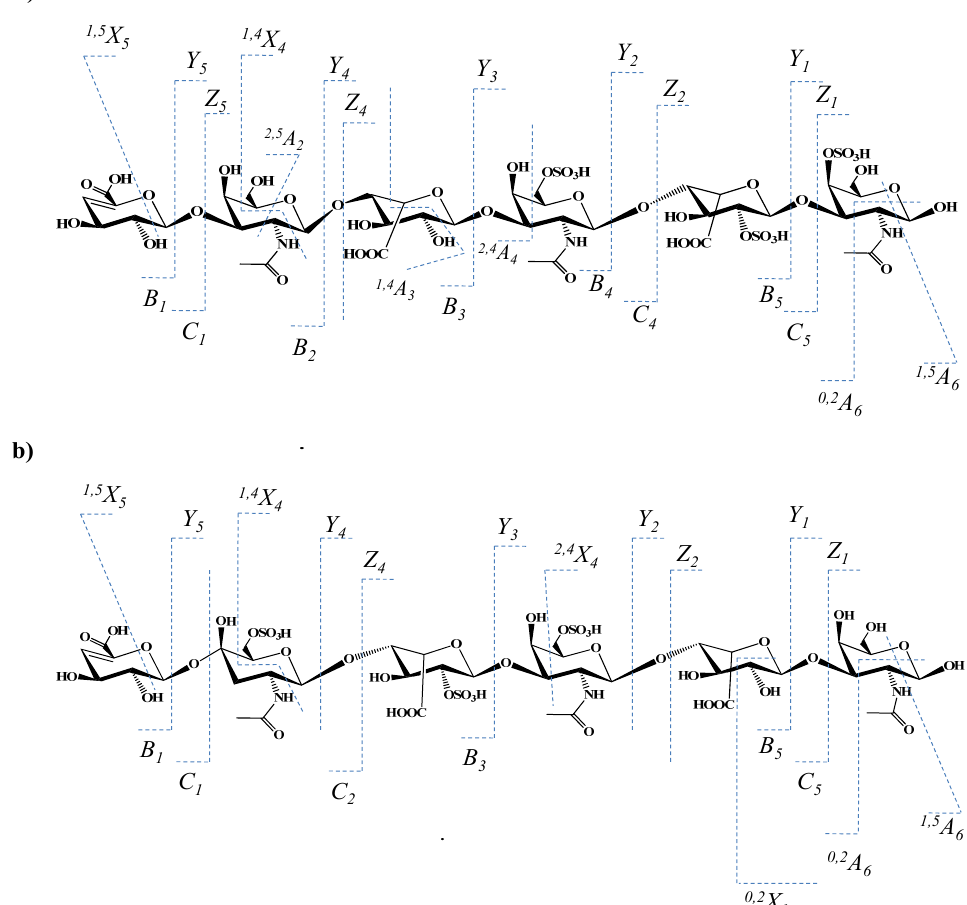
Figure 8. The two proposed structures with three sulfates located at the GalNAc-IdoA-GalNAc trisaccharide sequence from ( a ) the reducing or the ( b ) non-reducing end, together with the fragmentation pathways and the observed fragment ions for the trisulfated 4,5- Δ -GlcAGalNAc[IdoAGalNAc] 2 . The series of fragment ions detected by CID support both structures depicted in Figure 8. Due to the symmetry of the inner GalNAc-IdoA-GalNAc-IdoA-GalNAc motif and the lack of an aglycone to be used as a “tag”, no fragment ion able to support or completely rule out the structure in Figure 8a may be generated. On the other hand, on the basis of the previous observations related to the unsulfated 4,5- Δ -GlcA, the structure in Figure 8b is to be supported solely by fragment ions from the non-reducing end, hav- ing the nonsulfated 4,5- Δ -GlcA as a “tag”, to yield 4,5- Δ -GlcA-GalNAc-IdoA-GalNAc with all three sulfates located in GalNAc-IdoA-GalNAc. In spite of the high sequence coverage provided by the CID experiment and the el- evated mass accuracy of the generated fragment ions, none of the diagnostic ions was detected in the MS/MS of the trisulfated 4,5- Δ -GlcAGalNAc[IdoAGalNAc] 2 species. However, given that the absence of a signal does not represent relevant information, in Figure 8a,b we propose two structural variants for the analyzed trisulfated hexasaccha- ride. However, since the IMS profile has shown a single mobility feature for the triply charged molecule at m/z 470.714, only one of these two glycoforms represents a genuine domain in the CS/DS chain. Without IMS, the occurrence of both isomeric motifs should have been considered. In view of the MS/MS issues presented above, we deem that the configuration presented in Figure 8a is the most probable one. Additional structural information was provided by a number of detected ring-cleavage ions: (a) the doubly deprotonated ion at m/z 543.091, assigned to 1,4 X 4 , documents that in the first GalNAc residue from the non-reducing end, C4 position is not sulfated in any of the two glycoforms shown in Figure 8; and (b) the monodeprotonated 2,4 X 2 for the structure in Figure 8a, or 2,4 X 4 /Y 2 for the structure in Figure 8b, detected at m/z 779.097, confirm that in any of the cases, the first GalNAc moiety from the non-reducing end is sulfated in position C6. 3. Materials and Methods 3.1. CS/DS Hexasaccharide Fraction HEK293 cells were transfected with human decorin cDNA following the previously described protocol [28]. 500 μ g of DCN were prepared as we have shown before [20]. Briefly, one liter of conditioned medium was collected; the secreted macromolecules